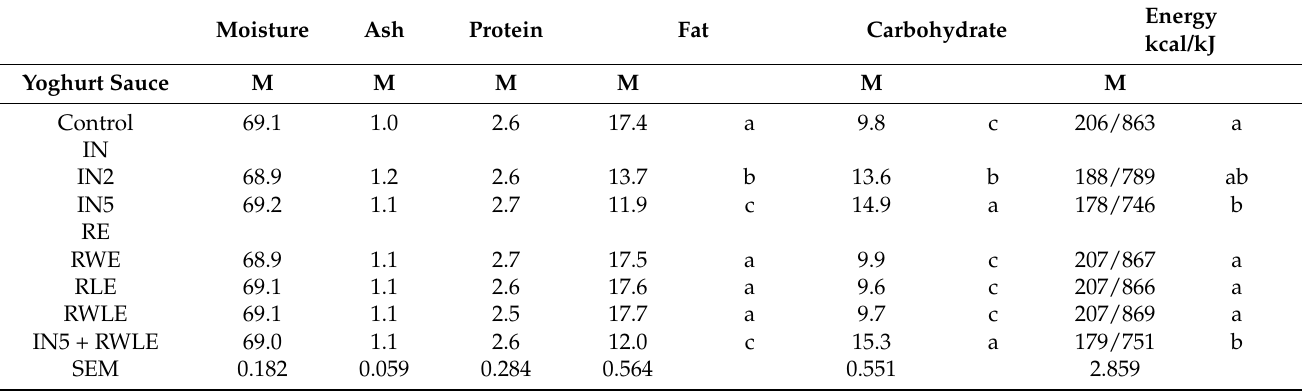
Table 2. Proximate composition (g/100 g) of yoghurt sauces made with inulin and/or rosemary